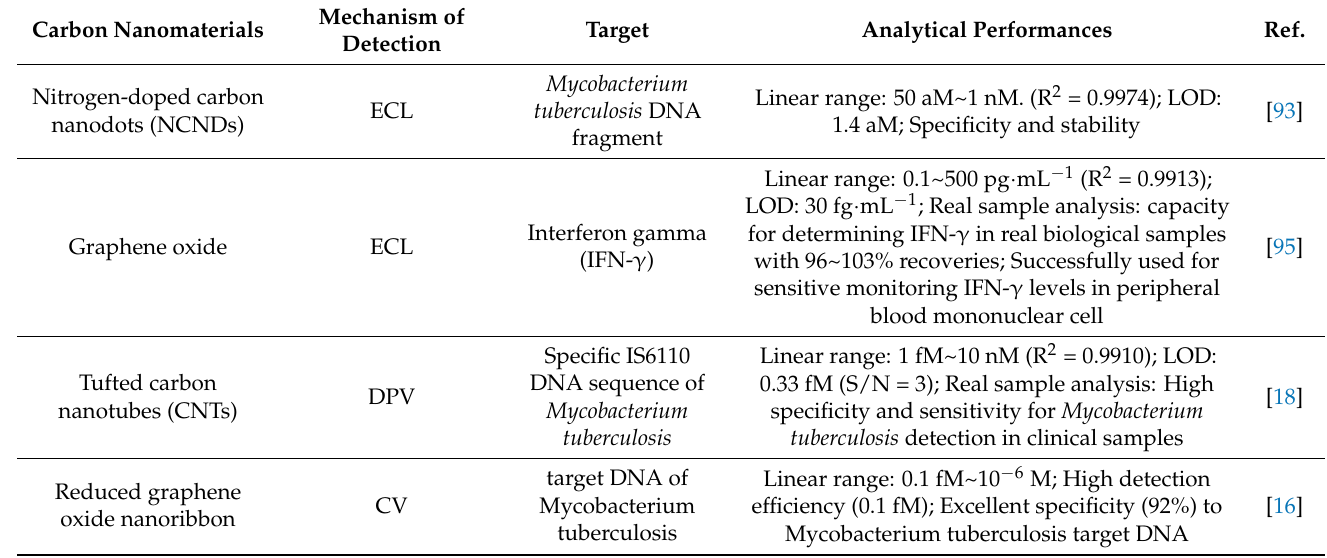
Table 4. Performances of electrochemical biosensors for tuberculosis diagnosis.